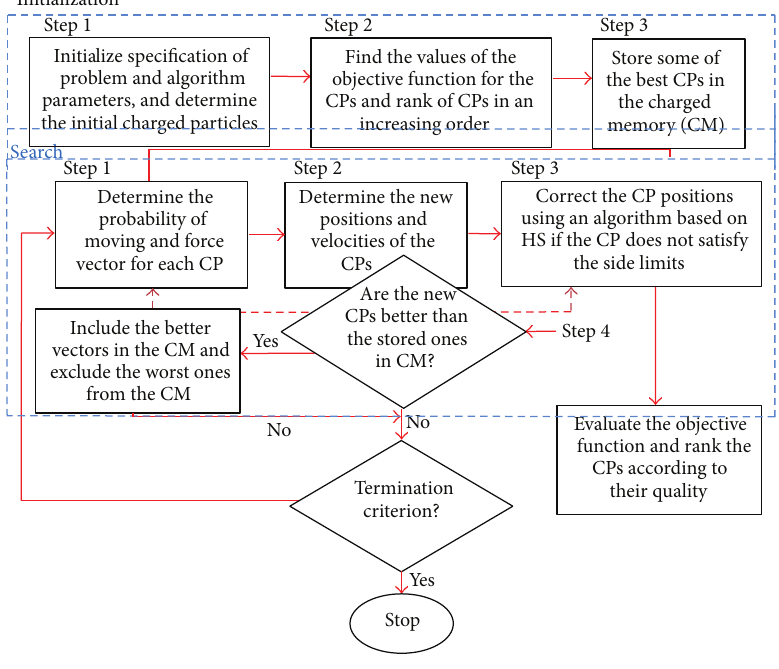
Figure 1: Flowchart of the CSS algorithm.